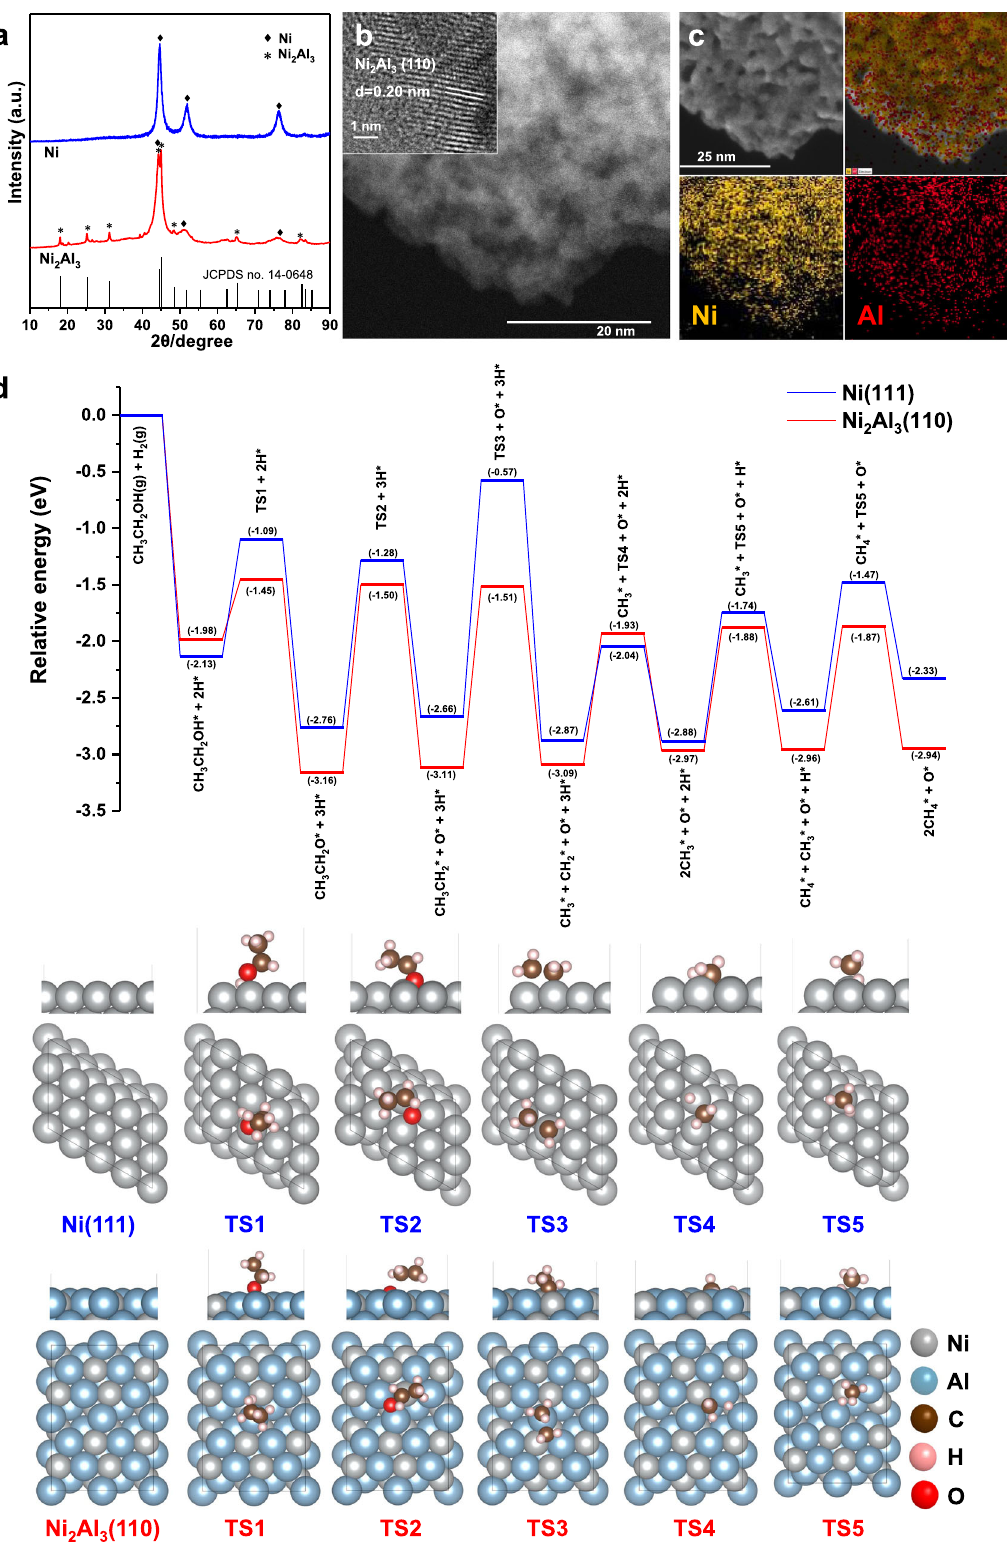
Fig. 2 Characterization of the nickel-based catalyst with Ni 2 Al 3 alloy phase and reaction pathways of ethanol compound. a XRD patterns of commercial nickel catalyst and nickel-based catalyst with Ni 2 Al 3 alloy phase (JCPDS card no. 14-0648). b High-resolution STEM images of the nickel-based catalyst with Ni 2 Al 3 alloy phase. c The energy-dispersive spectrometer (EDS) elemental maps of the nickel-based catalyst with Ni 2 Al 3 alloy phase. d Energy pro fi les for CH 3 CH 2 OH dissociation on Ni(111) and Ni 2 Al 3 (110) surfaces of C – O bond preferentially cleaved. The x axis shows the reaction intermediates, the y axis shows the relative energy of each